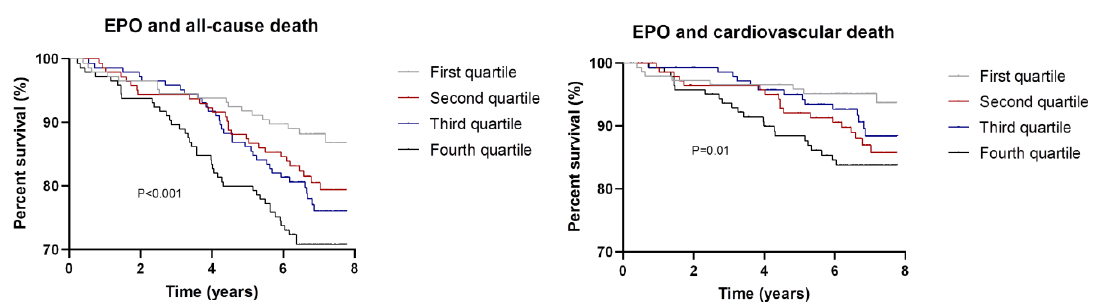
Figure 1. Kaplan–Meier Curves depicting the association between EPO quartiles and risk of all-cause (left panel) and cardiovascular death (right panel). Reported p-values have been calculated with the log-rank test for trend. Table 3. Association between erythropoietin quartiles and risk of all-cause and cardiovascular